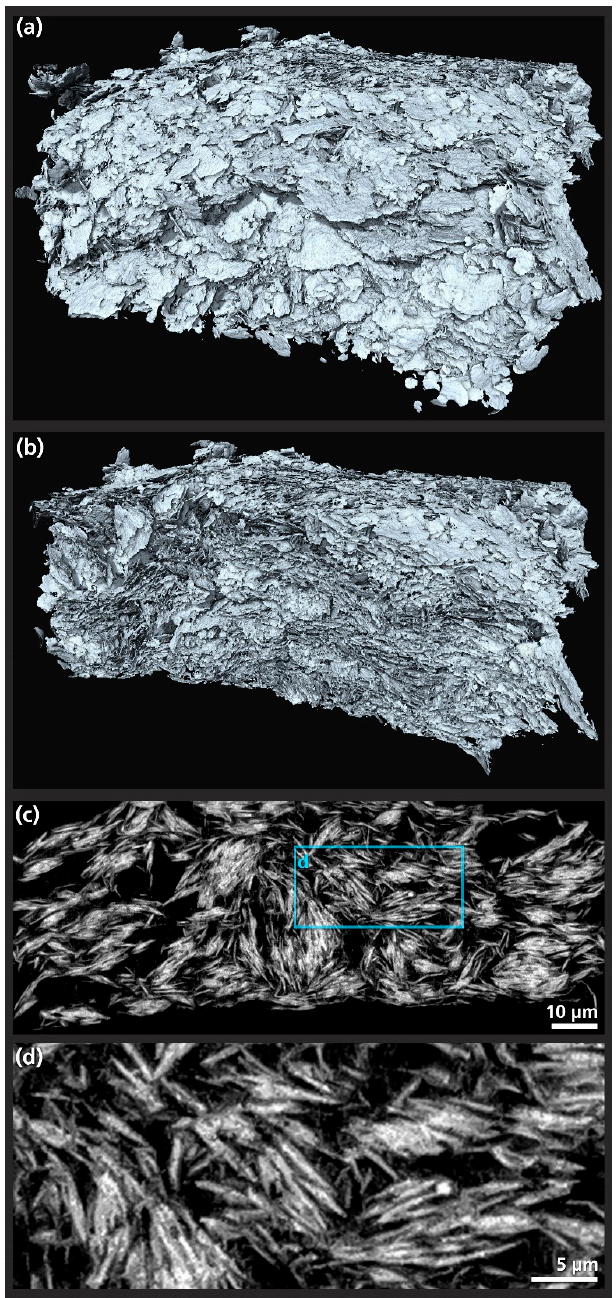
Figure 9. Reconstruction of the nano CT scan of the functional material composite. ( a ) 3D rendering of the whole reconstructed sample consisting of a flat cuboid with an edge length of about 100 µm. The rendering focuses on the metallic filler, whose orientation is essential for the function of the material. ( b ) sliced sample from the above rendering in which the self-organized alignment of the filler can be seen. ( c ) sectional image from the reconstruction, demonstrating that the particles have aggregated and locally compressed during the cyclic loading. ( d ) enlarged detail of the sectional image.